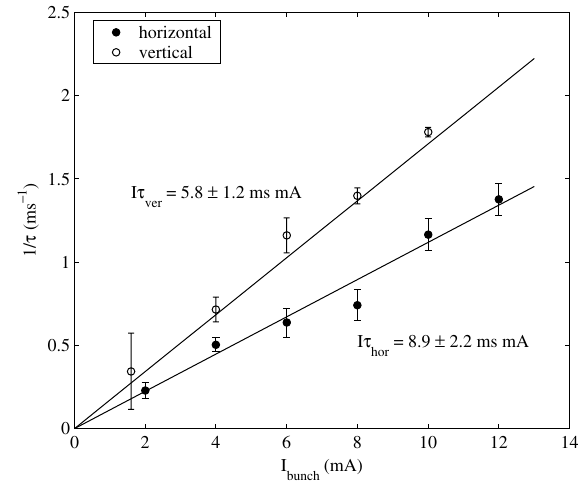
FIG. 5. Coherent head-tail damping.